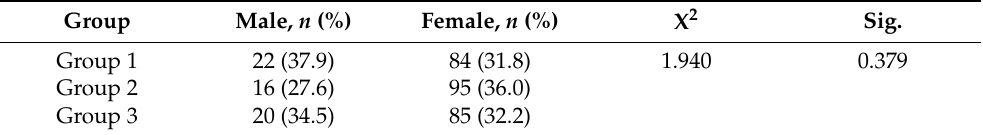
Table 2. Characteristics of the three groups of nursing students (Chi-squared tests). Group Male, n (%) Female, n (%) X 2 Sig.